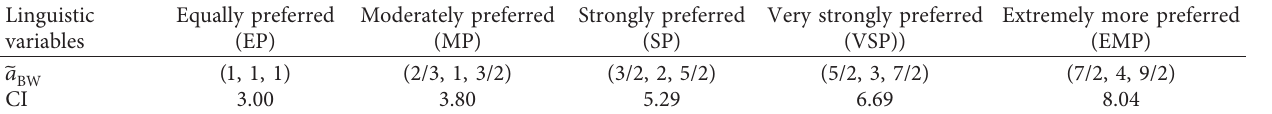
Table 2: Consistency index (CI) for FBWM.